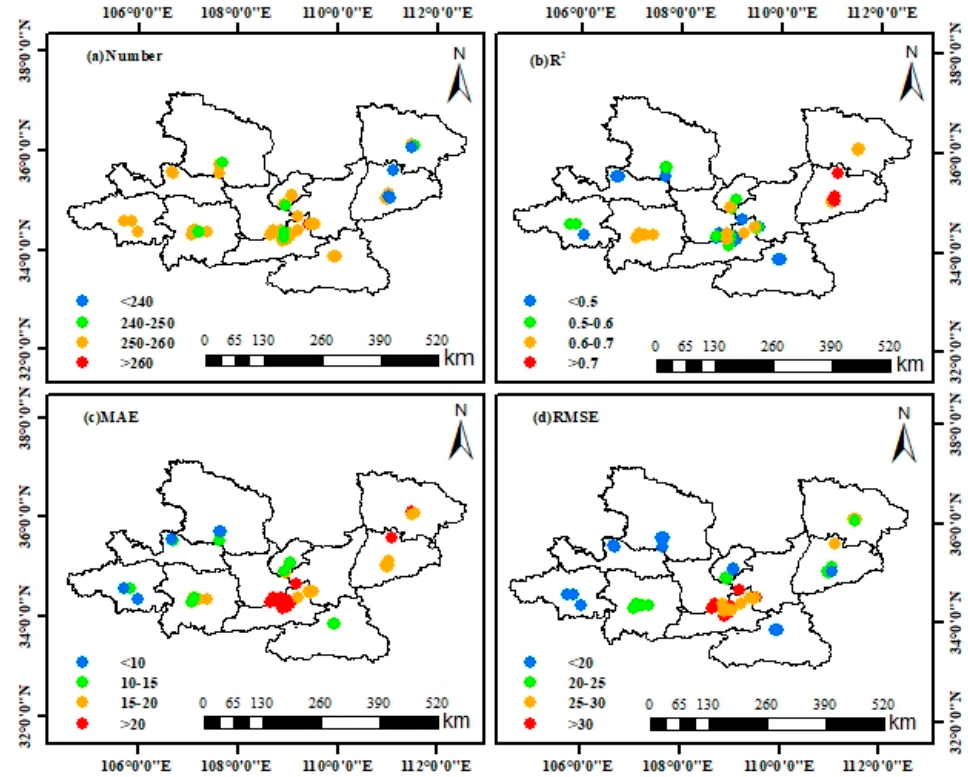
Figure 8. Spatial distributions of ( a ) the number of examined samples (N) at each monitoring station, ( b ) R 2 , ( c ) MAE ( μ g/m 3 ), and ( d ) RMSE ( μ g/m 3 ) between PM 2.5 predictions and measurements from